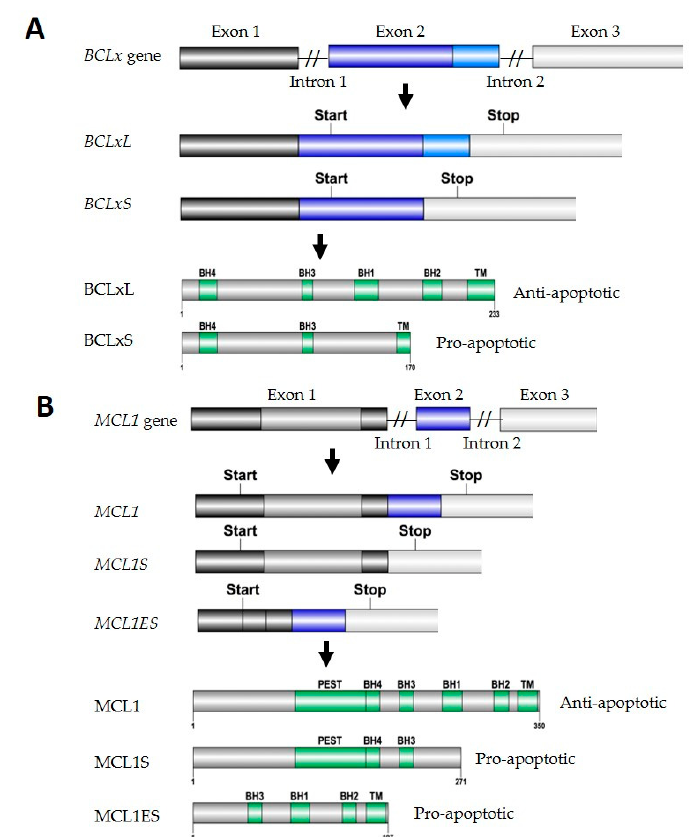
Figure 2. Alternative splicing of BCLx and MCL1 . Each panel represents an alternative splicing process from a pre-mRNA containing both introns and exons, to alternatively spliced mature mRNA isoforms, to different multi-motif protein products (L, long; S, short; ES, extra short). The 3 ′ end of each gene is truncated. The translational start and stop sites are specified on each alternatively spliced mature mRNA variant. Lastly, the impact of each protein product on apoptosis regulation is listed.